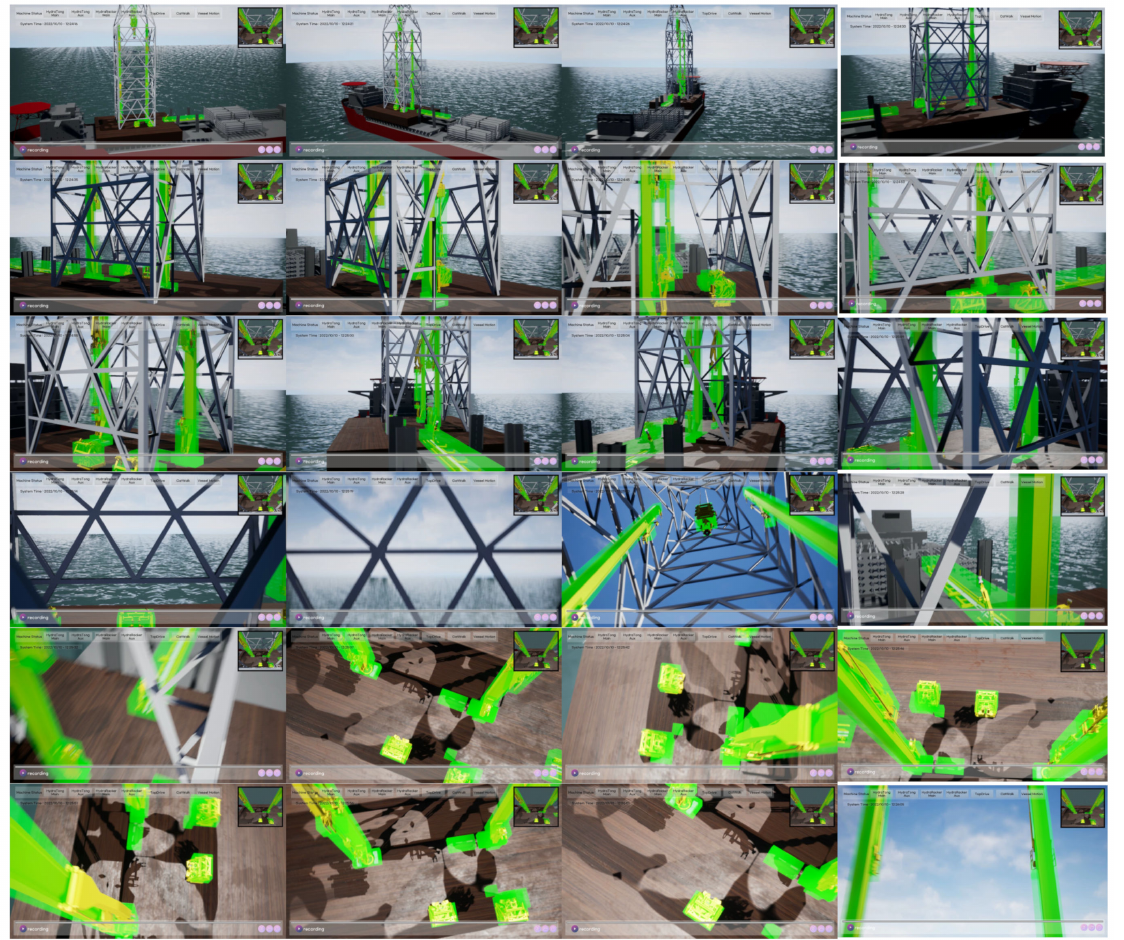
Figure 11. The operator moves the viewpoint and monitors the operation status of drilling equipment in the real-time